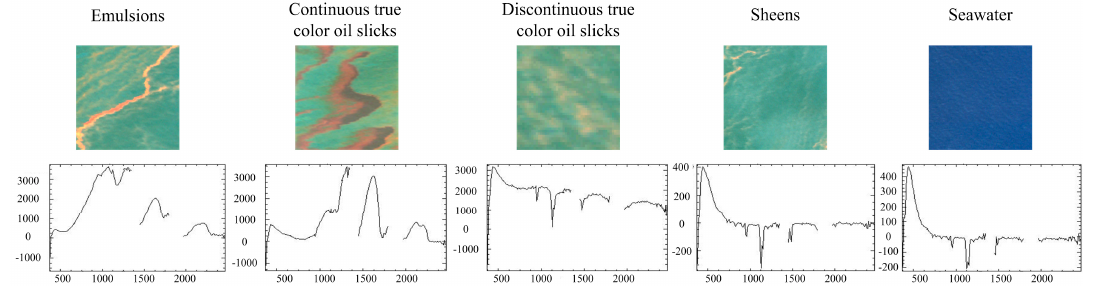
Figure 5. Images of different thicknesses of oil slicks and their spectral curves.